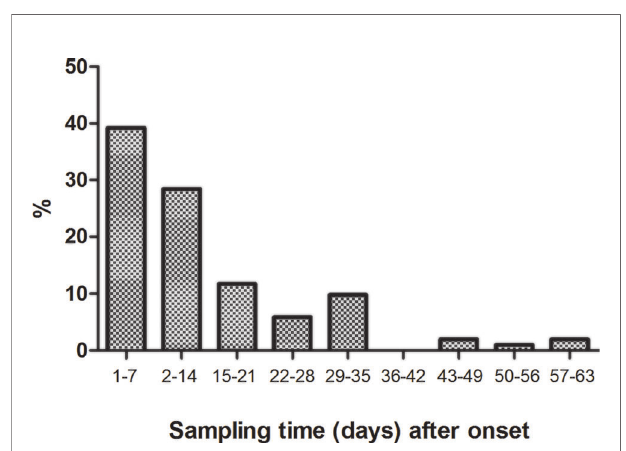
FIGURE 2 | Histogram (fraction of patients) showing time delay (days) between onset of disease ( fi rst symptoms)